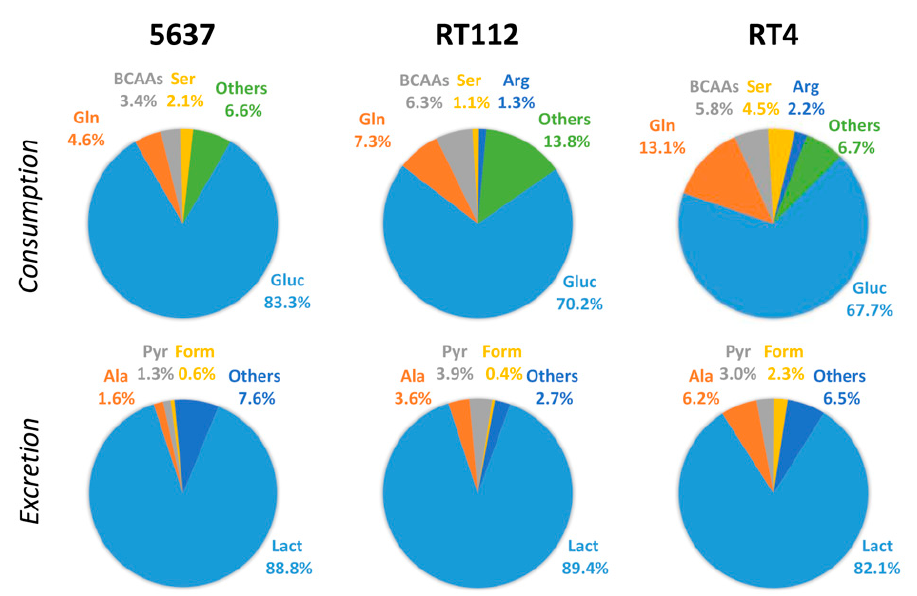
Figure 5. Diet composition ( top line) and excretion ( bottom line) of the three cell lines. Abbrevations used: Ala: alanine, Arg: arginine, BCAAs: branched-chain amino acids, Form: formate, Gluc: glucose,